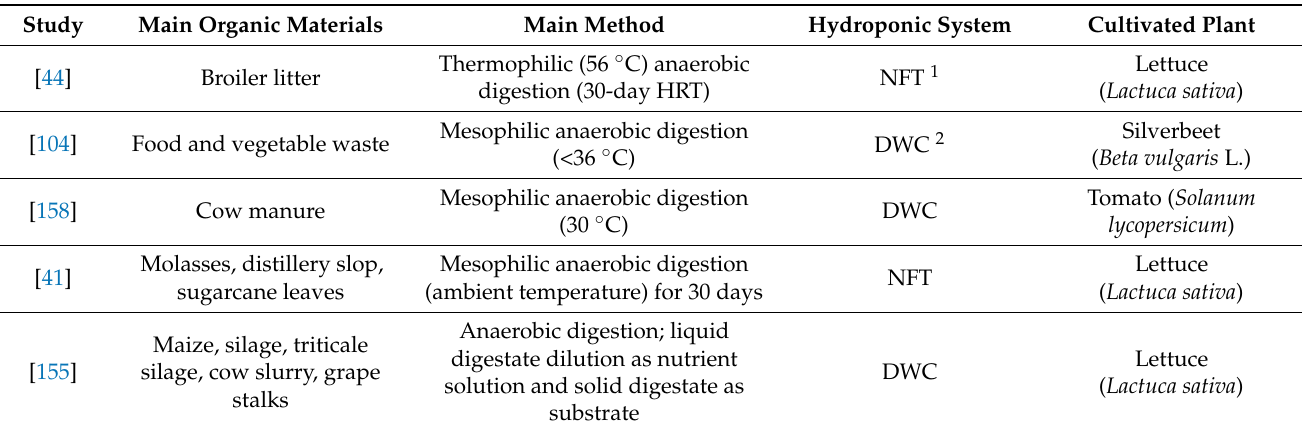
Table 5. Main organic materials and method of anaerobic digestion for the production of nutrient solution used in different types of